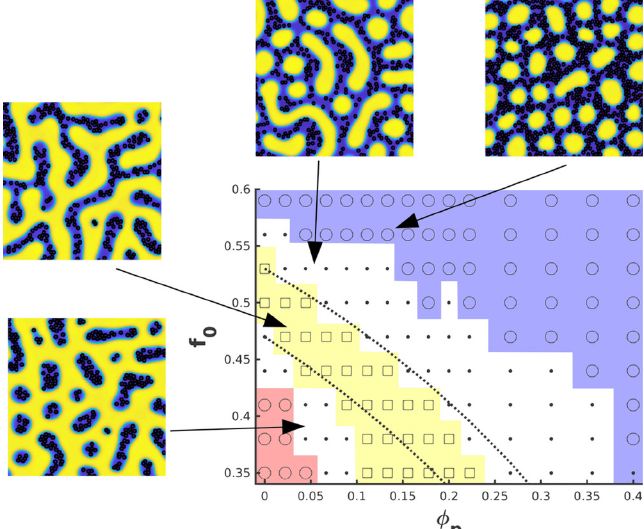
Figure 10. Morphology of a BCP/NP system with a f 0 ratio and φ p NPs which are strongly compatible toward one of the phases. The BCP is in the strong segregation regime. Shown phases are circular phase (circles), mixed phase (dots) and lamellar (squares). Reprinted with permissions from Ref. [57], Copyright 2018 Wiley